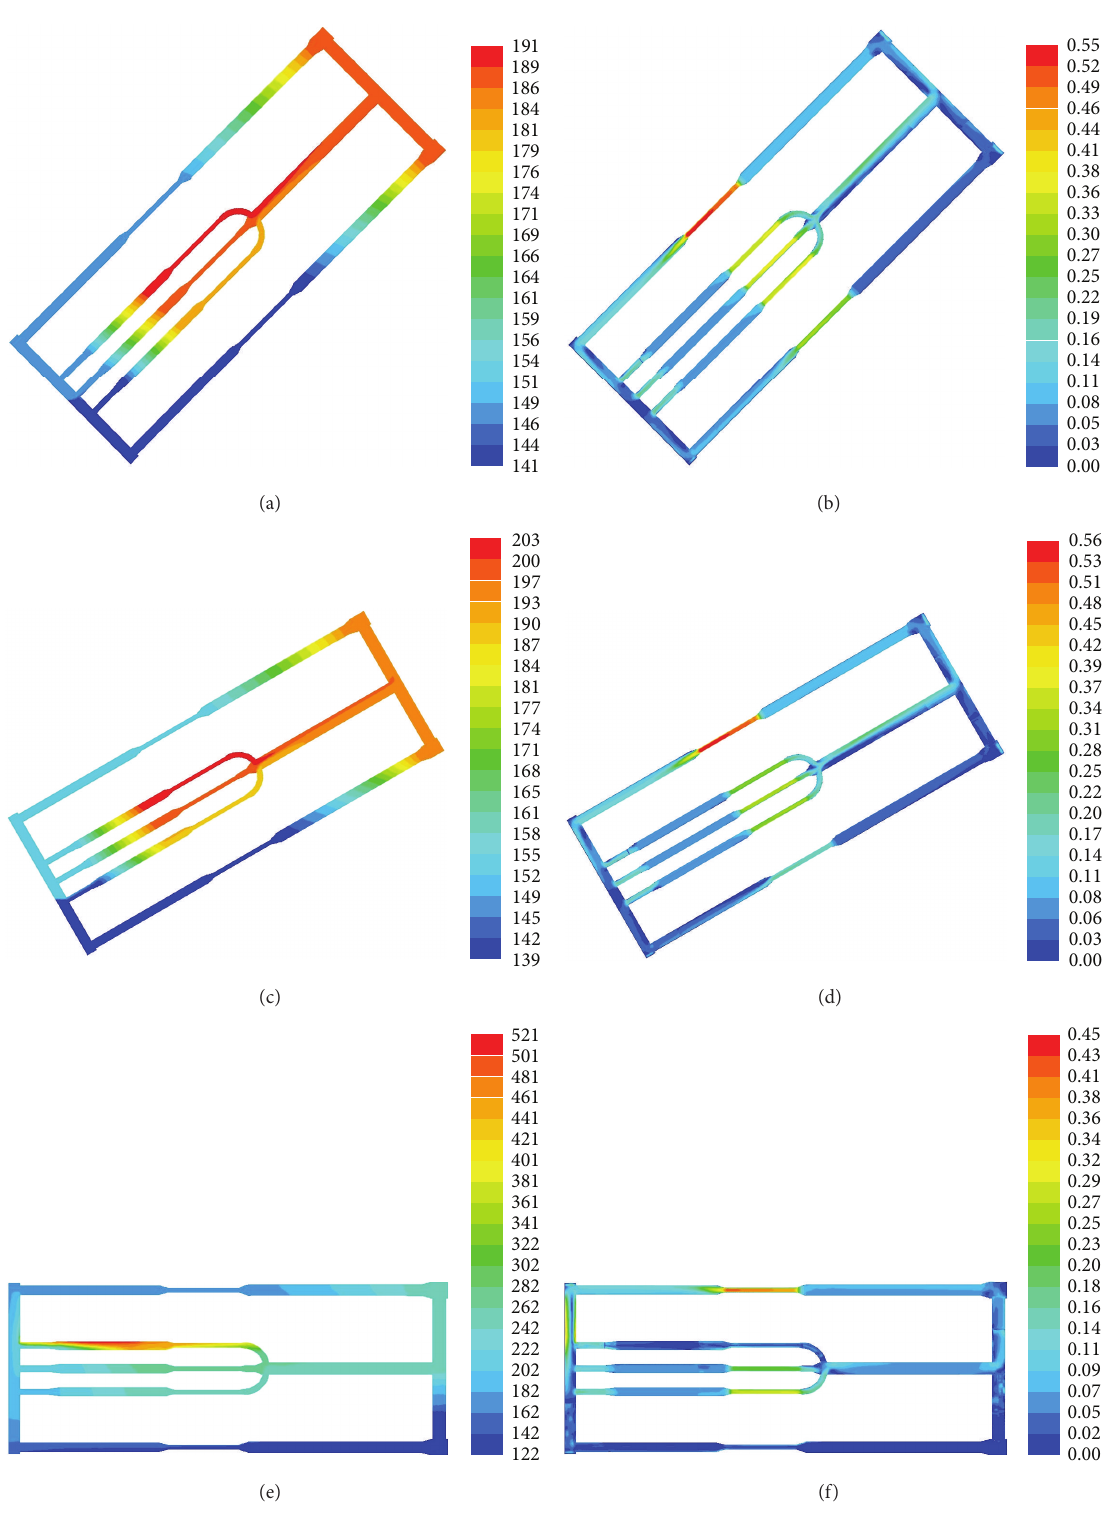
Figure 7: Flow fields in the test section: (a) 45 ∘ , temperature field; (b) 45 ∘ , velocity field; (c) 60 ∘ , temperature field; (d) 60 ∘ , velocity field; (e) 90 ∘ , temperature field; (f) 90 ∘ , velocity